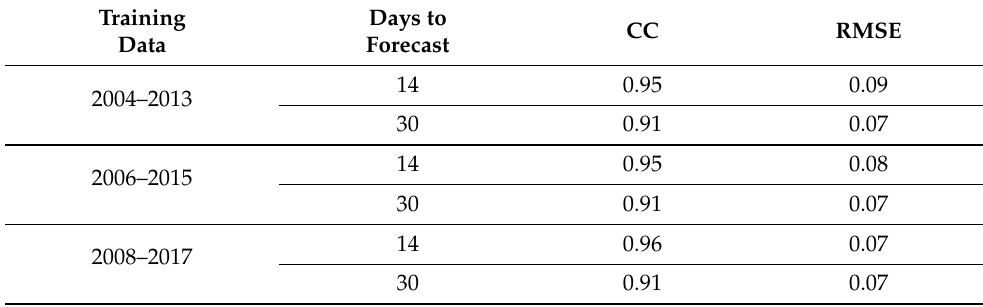
Table 4. Results of predictions using three different time frames of 10 years of training data.